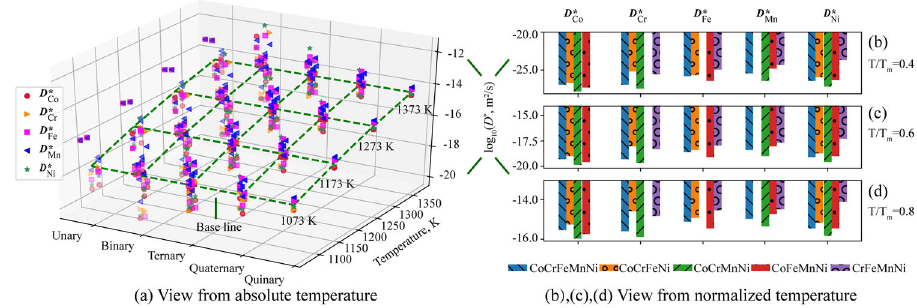
Fig. 9 Relation between diffusion rates and variation of con fi gurational entropy. a View from absolute temperature: Deviation of the effective tracer diffusion coef fi cients over various matrices against the quinary system at different temperatures; b View from normalized temperature: Tracer diffusion coef fi cients of various components on the selected matrices at normalized temperatures.